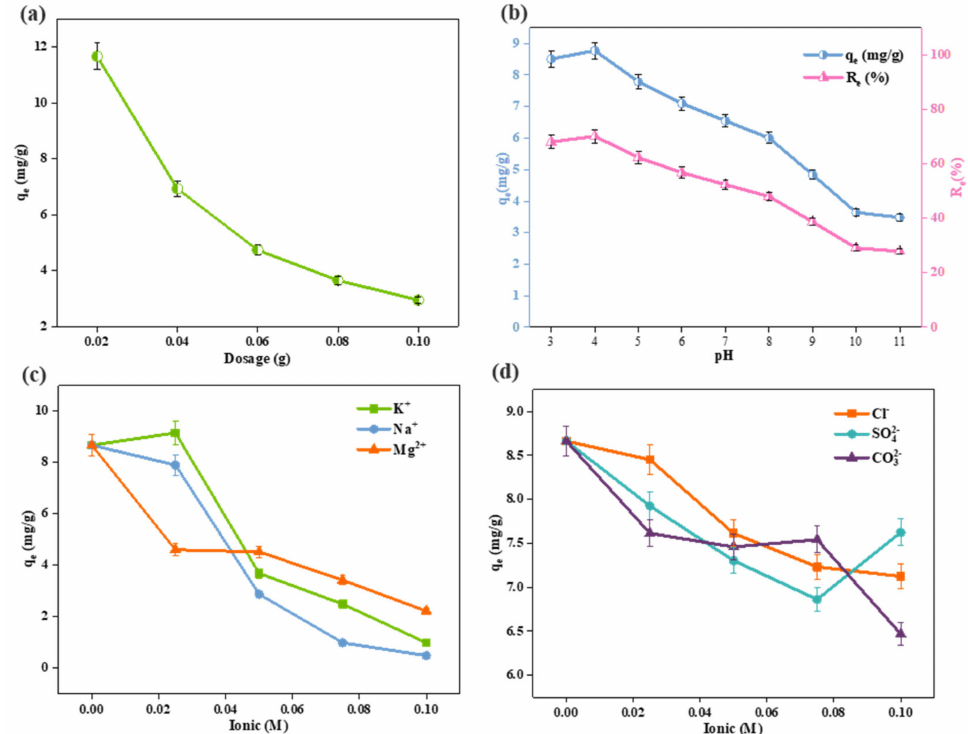
Figure 4. ( a ) E ff ect of adsorbent dosage on CIP adsorption capacity (initial CIP concentration: 20 mg · L − 1 , initial pH:7), ( b ) e ff ect of initial pH on CIP adsorption by CA-Al-KABs (initial CIP concentration: 20 mg · L − 1 , m / v: 0.04 g / 50 mL), ( c ) and ( d ) e ff ects of cationic strength (c) and anionic strength (d) on CIP adsorption in binary solution and in multicomponent solution by CA-Al-KABs (initial CIP concentration: 20 mg · L − 1 , m / v: 0.04 g / 50 mL, initial